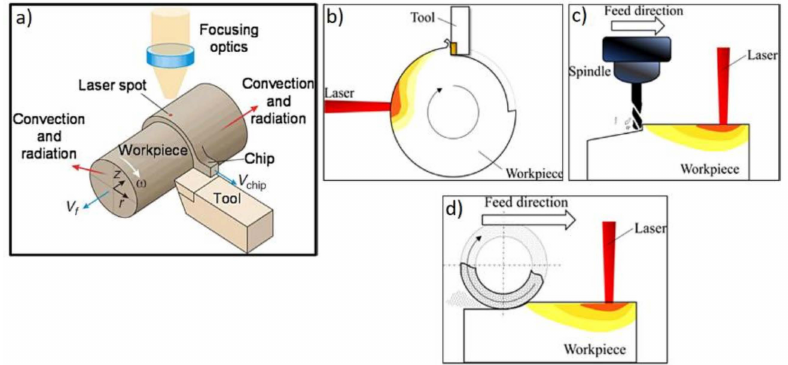
Figure 8. ( a ) Schematic of LAM indicating heat-losses by convection and radiation, ( b ) Schematic of LAM turning, ( c ) LAM milling, and ( d ) LAM grinding (adapted from [75]) (Caption: V f —feed velocity).